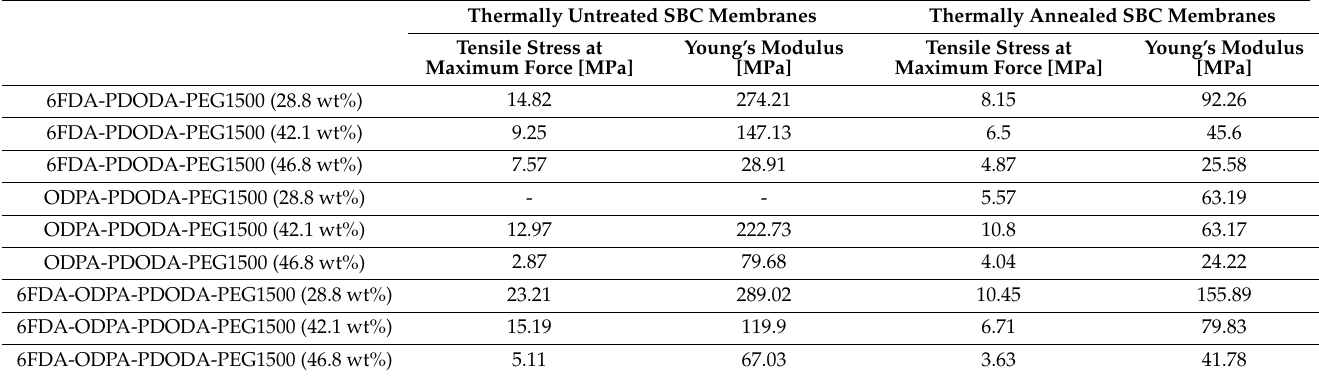
Table 7. Tensile stress at maximum force and the Young’s modulus of the SBC membranes with changing PEG content (Dianhydride entities are written in bold text). Thermally Untreated SBC Membranes Thermally Annealed SBC Membranes